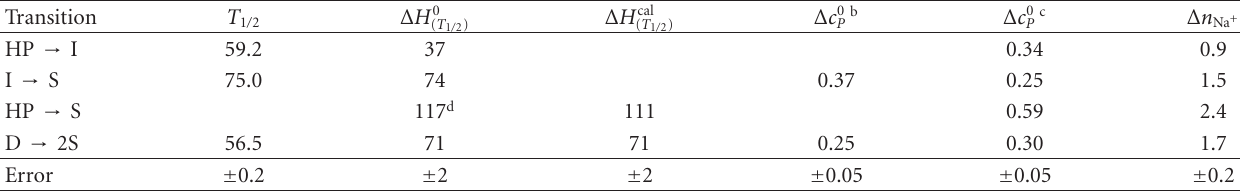
Table 1: Thermodynamic parameters a obtained from fitting the model functions ((14) and (18)) to the duplex (D) and hairpin (HP) DSC thermograms presented in Figure 2.